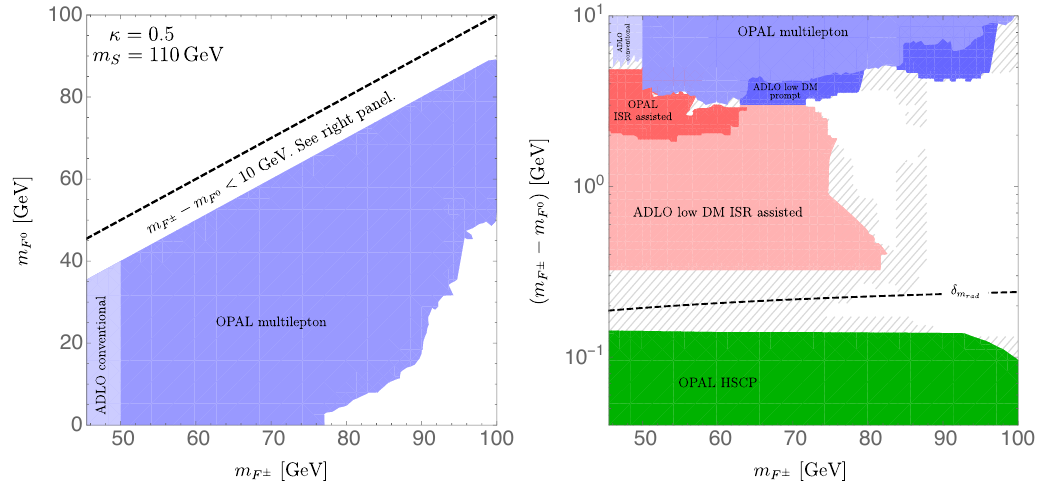
Figure 9 . Limits on charginos F (cid:6) (from the simpli(cid:12)ed model of section 3), set by the searches in table 1, in the uncompressed region (left) and in the compressed region (right). The coupling is set to (cid:20) = 0 : 5 and the scalar singlet mass to m S = 110 GeV. All the searches included present